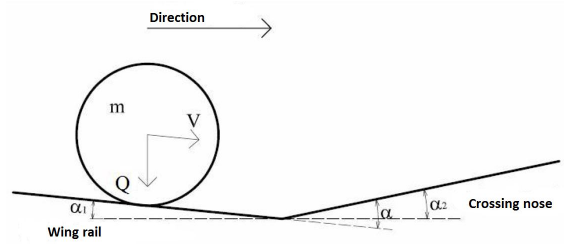
Figure 2. Simplified model of wheel movement through the crossing part [3].